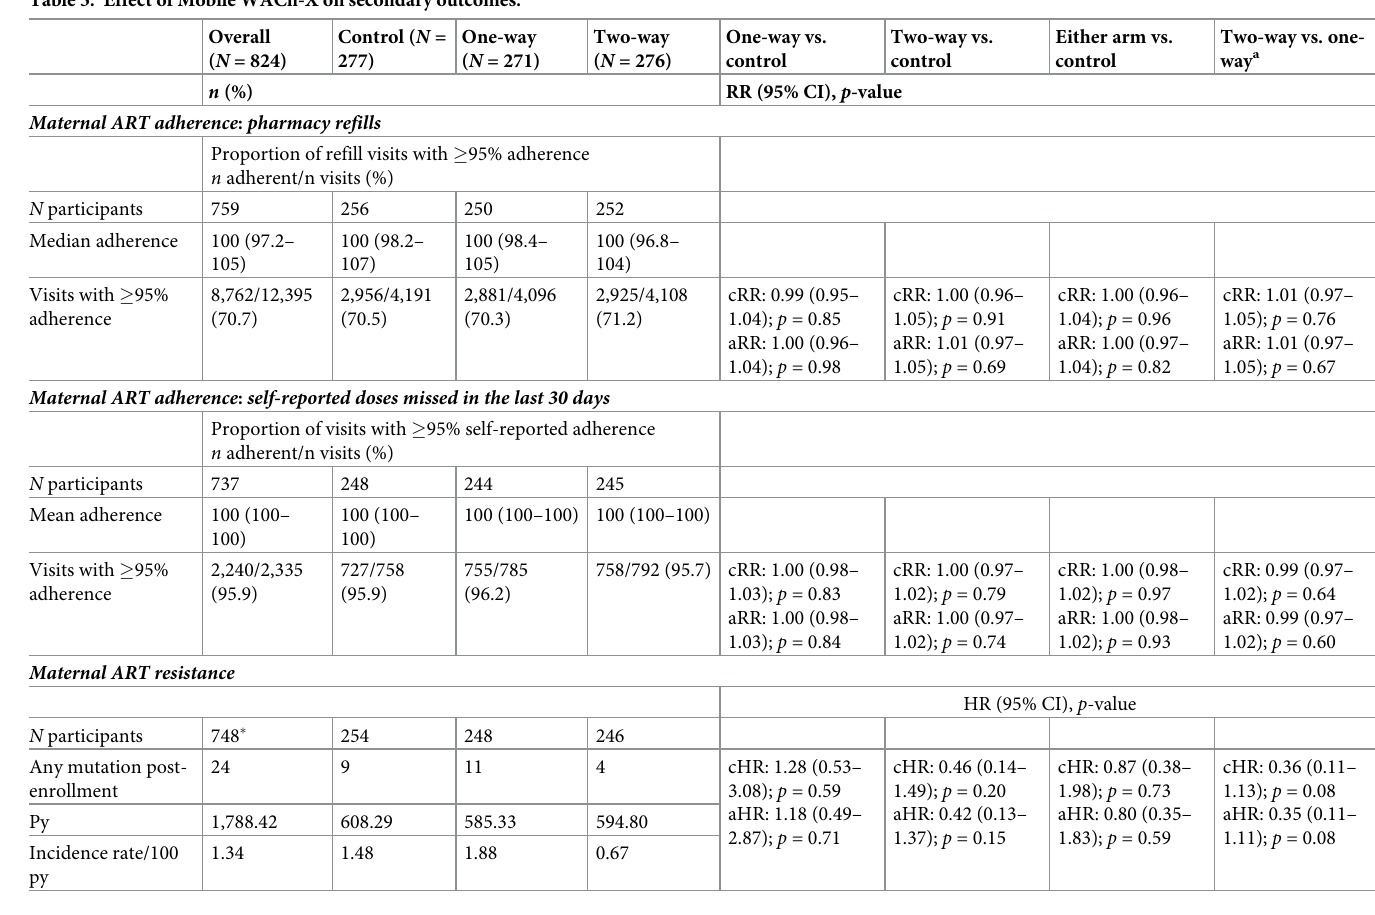
preceding visit that � 95% of days in the interval were covered by ART doses dispensed at the pre- ceding visit. There were no significant differences between intervention and control (1-way aRR of high adherence: 1.00 [0.96 to 1.04], p = 0.98; 2-way aRR: 1.01 [0.97 to 1.05], p = 0.69). A total of 737 participants had self-reported ART adherence data from 2,335 study visits. Median ART self- reported adherence was 100% (IQR 100 to 100), and self-reported ART adherence � 95% was reported at a total of 2,240 visits (95.9%), with no significant differences by arm (Table 3). Of 748 participants without ART resistance at enrollment, 282 (37.7%) qualified for resis- tance testing. Among these participants, 24 developed an ART resistance mutation, for an inci- dence of 1.34/100 py. There were no significant differences between intervention versus control (1-way aHR: 1.19 [0.49 to 2.89], p = 0.70; 2-way aHR: 0.42 [0.13 to 1.37], p = 0.15). Viral suppression results were similar in subgroup analyses stratified by age, phone sharing, pregnancy history, employment, HIV status disclosure, education, baseline VL, and baseline ART resistance (S1 Fig).